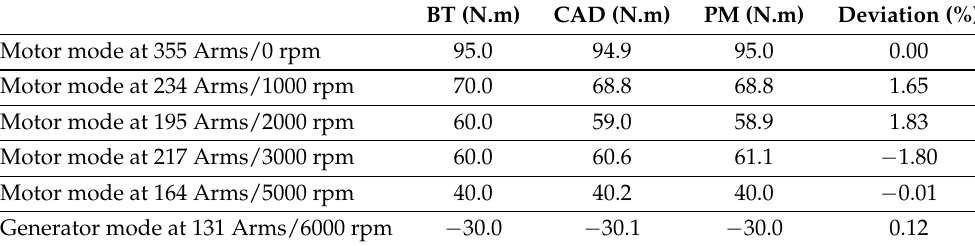
Table A3. Comparison results for on-load